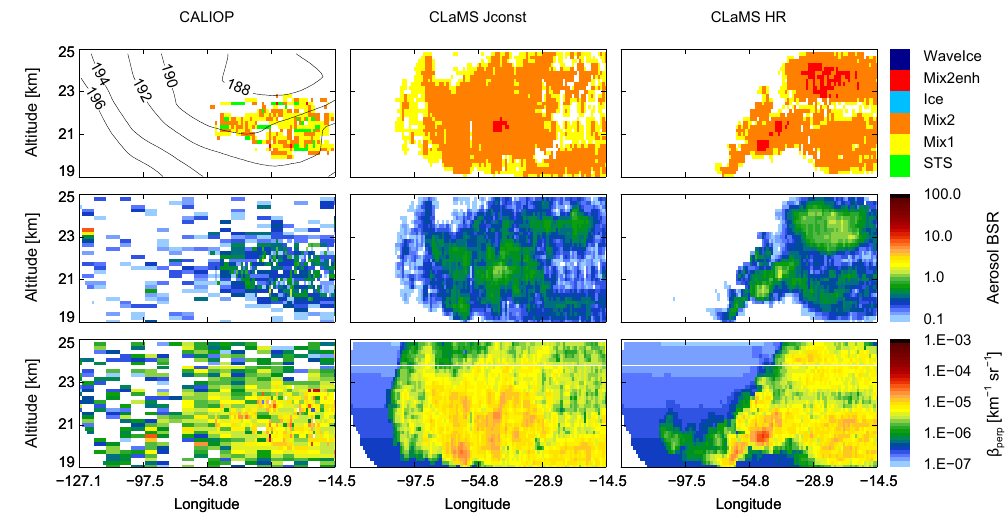
Fig. 7. As Fig. 6, but for 30 December 2009,